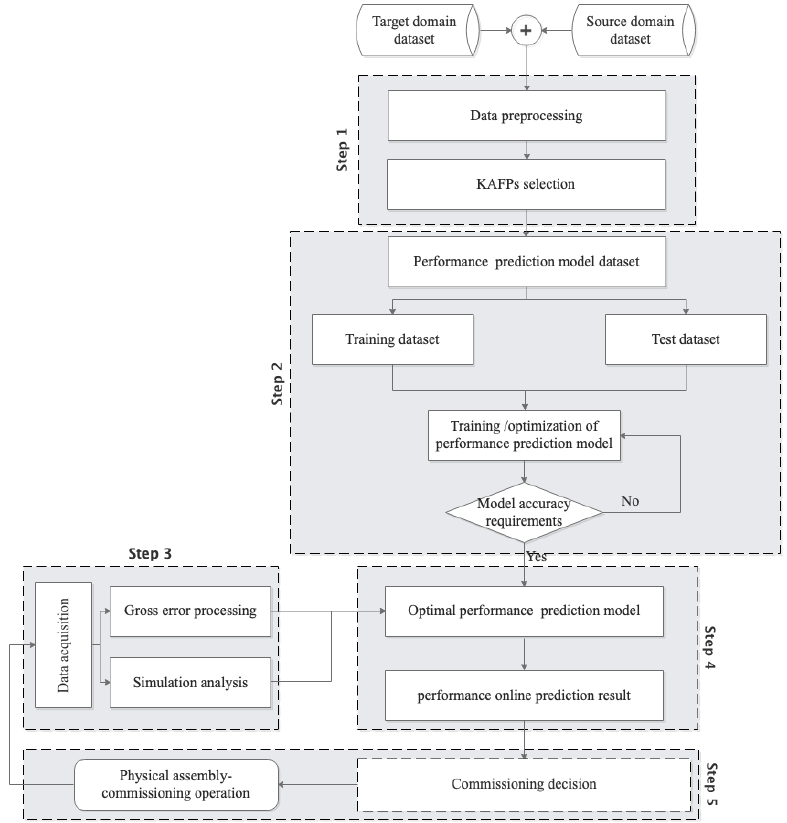
Figure 3. The flowchart of the proposed performance prediction method.